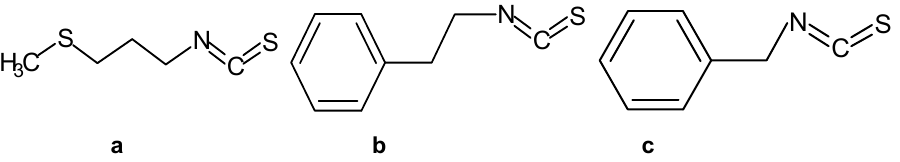
Figure 1. Structures of isothiocyanates (ITCs). ( a ) 3-methylthiopropyl isothiocyanate (MTPITC), ( b ) phenethyl isothiocyanate (PEITC), and ( c ) benzyl isothiocyanate (BITC).